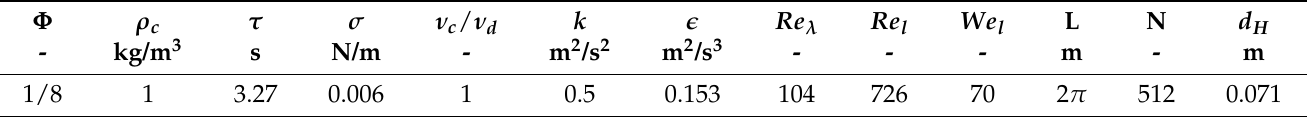
Table 1. Constant parameters for all